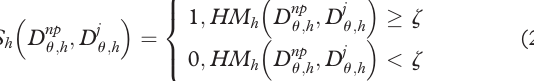
algorithm, the antibody incentive is de fi ned to measure the antibody quality. Better incentive is achieved with higher af fi nity with the antigen and lower antibody density. In our problem, a lower v np value indicates the higher af fi nity total ; h with the antigen. Low incentive re fl ects the high quality of antibodies, which should be motivated to get cloned and mutated. Thus, the incentive can be calculated by